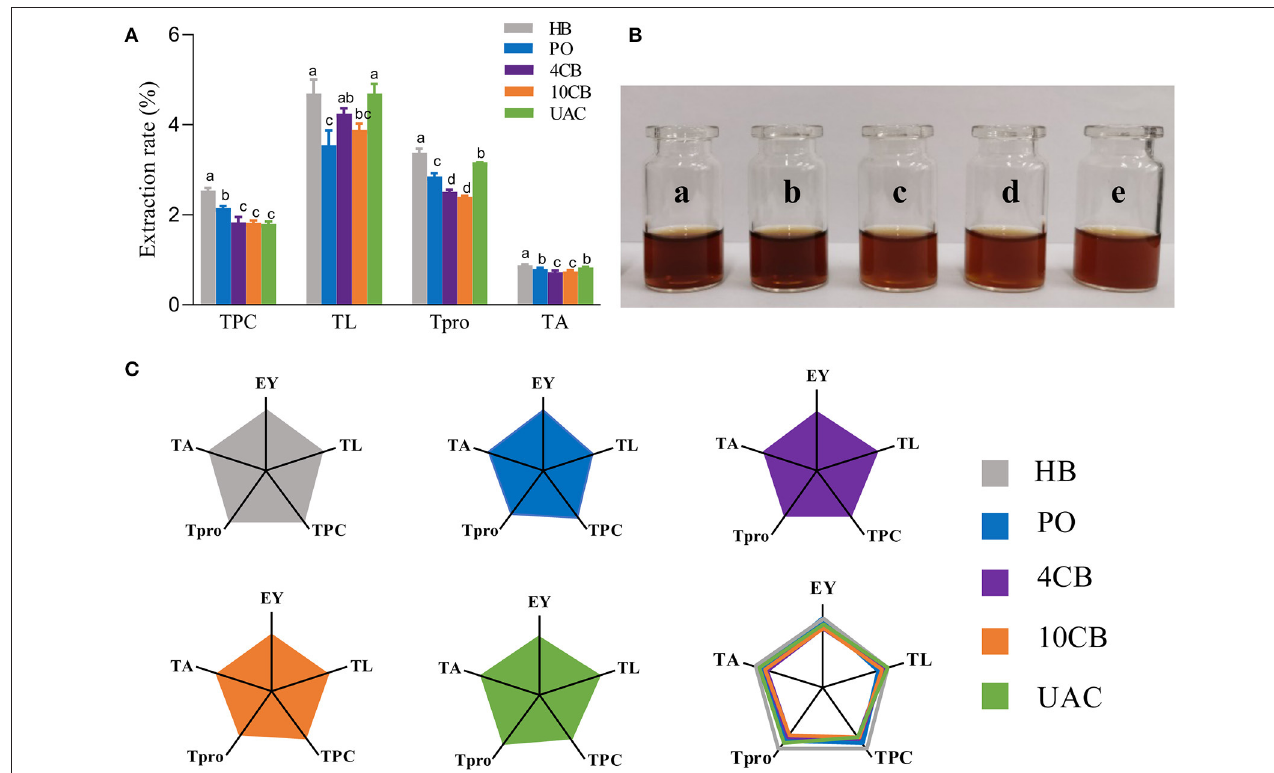
FIGURE 1 | (A) The effects of different brewing methods on TPC, TO, Tpro, and TA. Different letters indicate statistically significant differences ( p < 0.05) among treatments. (B) Actual images of a) hot boiled, b) pour-over, c) 4 ◦ C cold brew, d) 10 ◦ C cold brew, and e) ultrasound-assisted cold brewed coffee samples. (C) Spider plots of main physicochemical characteristics yielded by hot and cold brewing coffee methods. EY, Extraction yield; TL, total lipid extraction rate; TPC, total phenolic extraction rate; Tpro, total protein extraction rate; TA, total acid extraction rate. HB, Hot boiled, PO, Pour-over, 4 CB, 4 ◦ C cold-brew, 10 CB, 10 ◦ C cold brew, UAC, Ultrasound-assisted cold